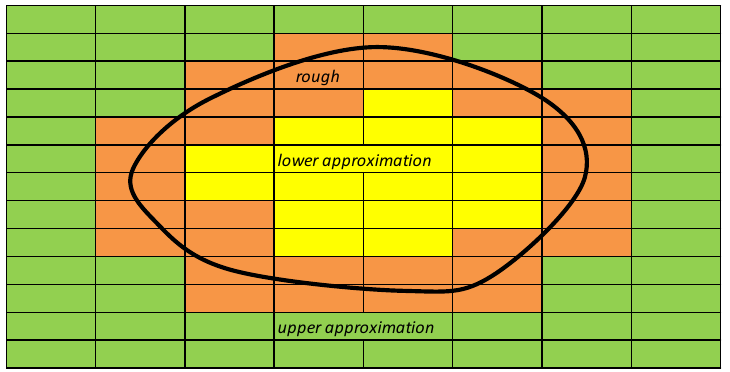
Figure 2. Representation of approximation sets.